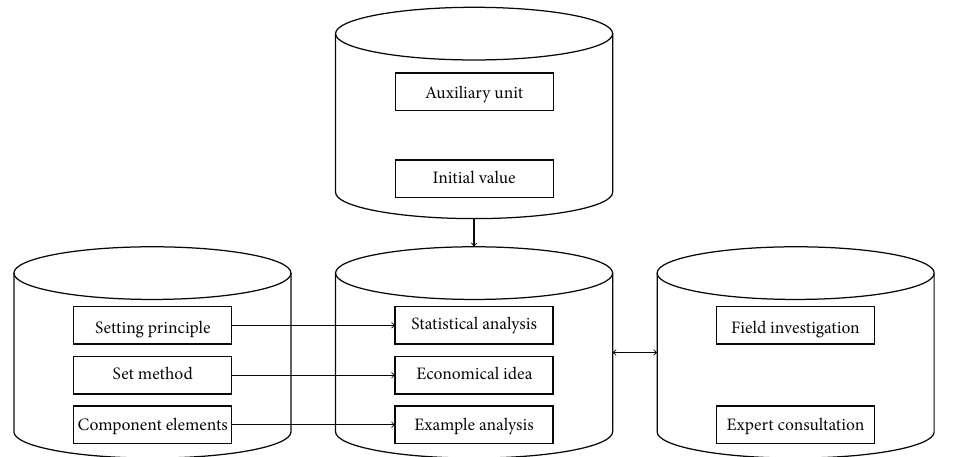
Figure 1: Road map of environmental protection and energy conservation public landscape